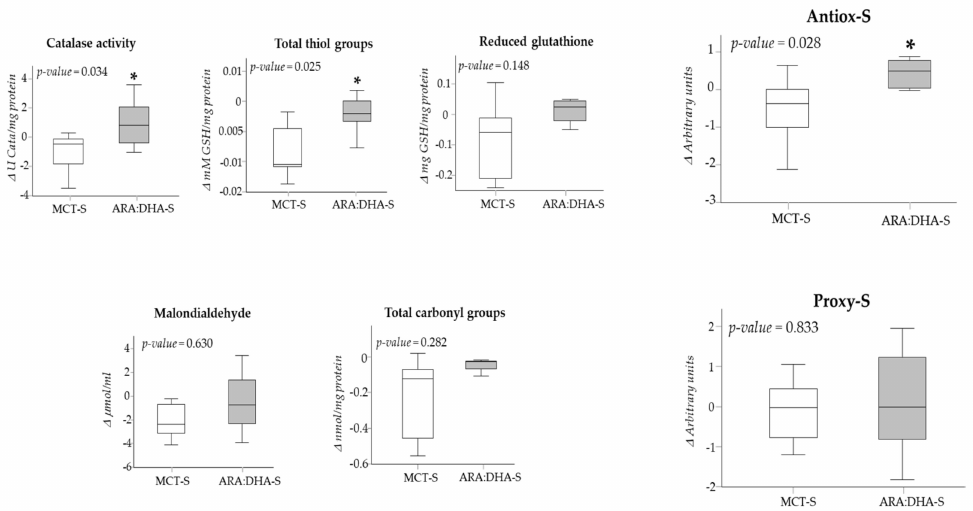
Figure 2. Changes in plasma antioxidants, the global antioxidant score (Antiox-S), biomarkers of oxidative damage, and the global score of oxidative damage (Proxy-S) from birth to 36 weeks of postmenstrual age according to MCT ( n = 8) or ARA:DHA ( n = 6) supplementation. Data show medians and IQR. * p < 0.05; Mann–Whitney U